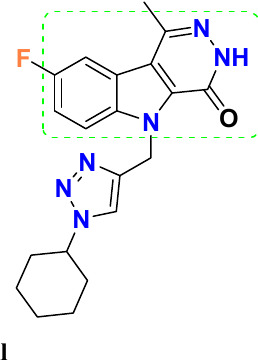
Figure 1. Bioactive pyridazino[4,5-b]indole.